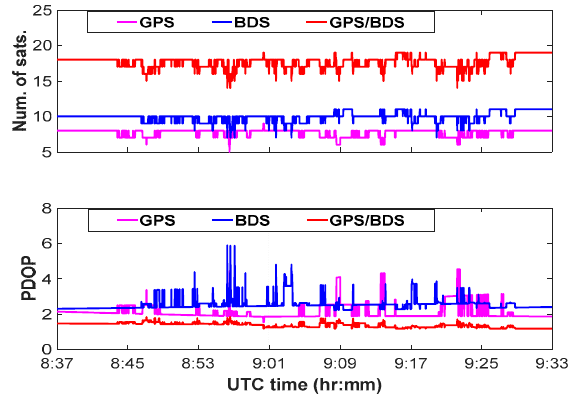
Figure 7. Satellites visibility in the test.